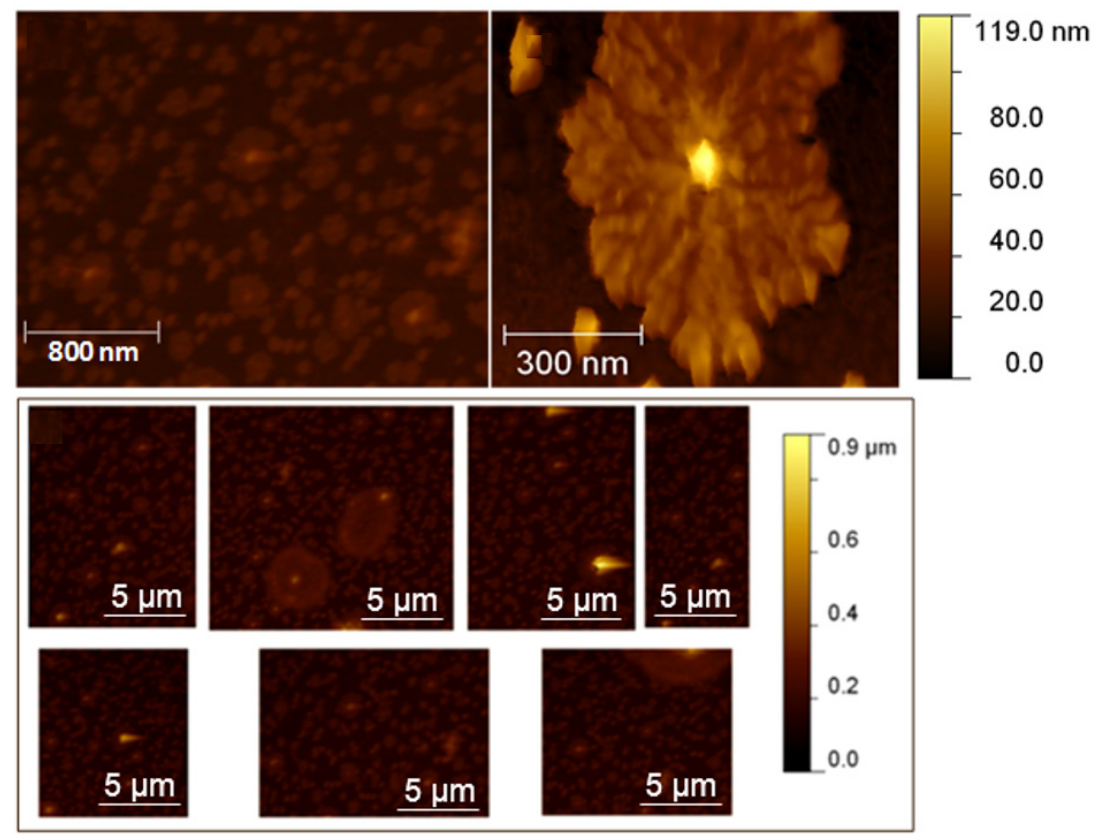
-AuNPs electrodes using the adsorption time of 120 minutes. 2 -AuNPs shows the distribution of 3